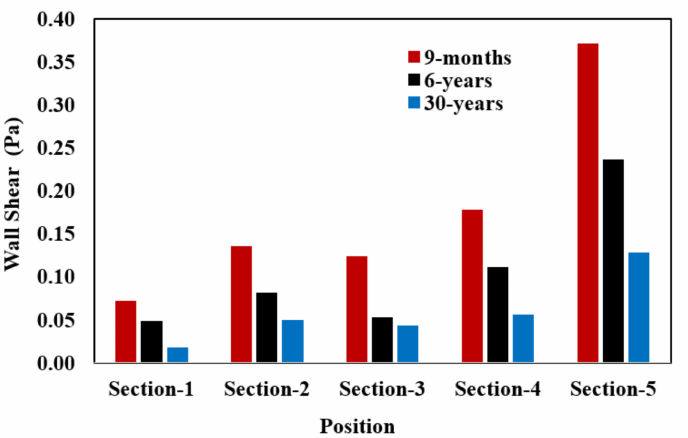
Figure 6. Averaged wall shear stress at a different section of the lung defined in Figure 1 for infant, child and adult ages.